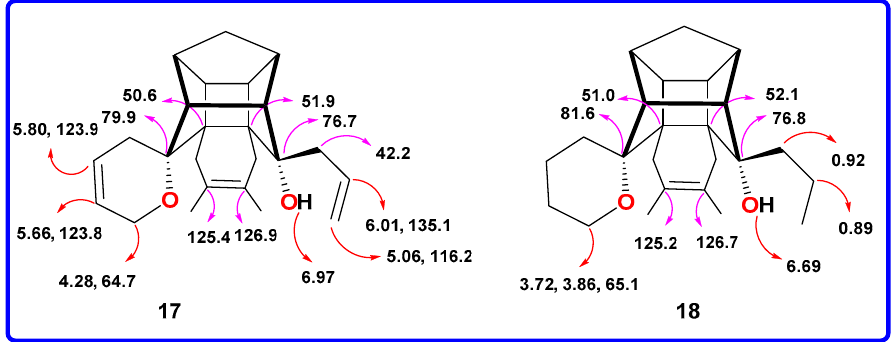
Figure 2. Comparison of NMR ( 1 H and 13 C) value(s) of targets 17 and 18